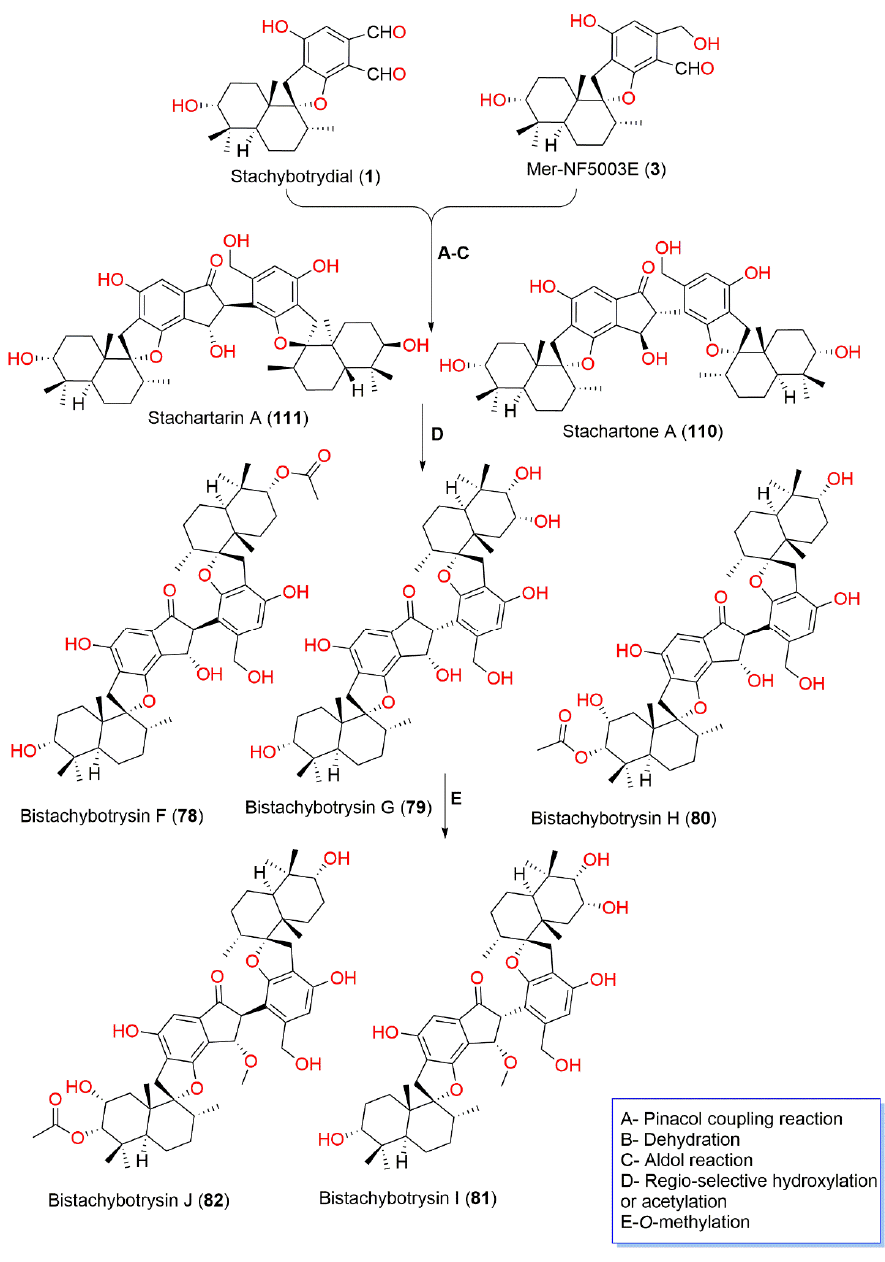
Scheme 6. Biosynthetic pathway of bistachybotrysins F–J ( 78 – 82 ) [81]. Bistachybotrysin K ( 83 ) is a new phenylspirodrimane dimer with a central 6/7 oxygen heterocyclic core. It displayed potent cytotoxic capacity versus NCI-H460, HCT116, Daoy, BGC823, and HepG2 (IC 50 ranged from 1.1 to 4.7 mM) in the MTT assay, revealing